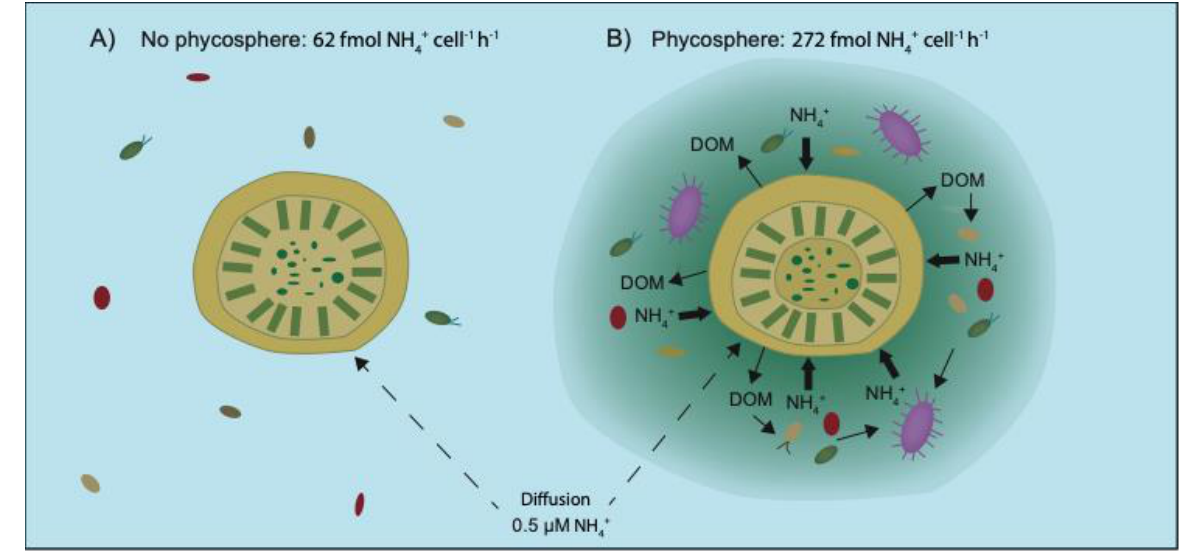
Figure 3. Schematic image of ammonium (NH 4 + ) assimilation via ( A ), diffusion only and ( B ), diffusion plus microbial interactions within the phycosphere. In panel B, bacterial recycling of dissolved organic matter (DOM) released by the diatom and protozoa grazing on bacteria together largely increase the ammonium availability, creating a gradient of elevated ammonium concentration around the diatom cell, decreasing with distance from the surface. Drawn based on results from Olofsson et al. [16].